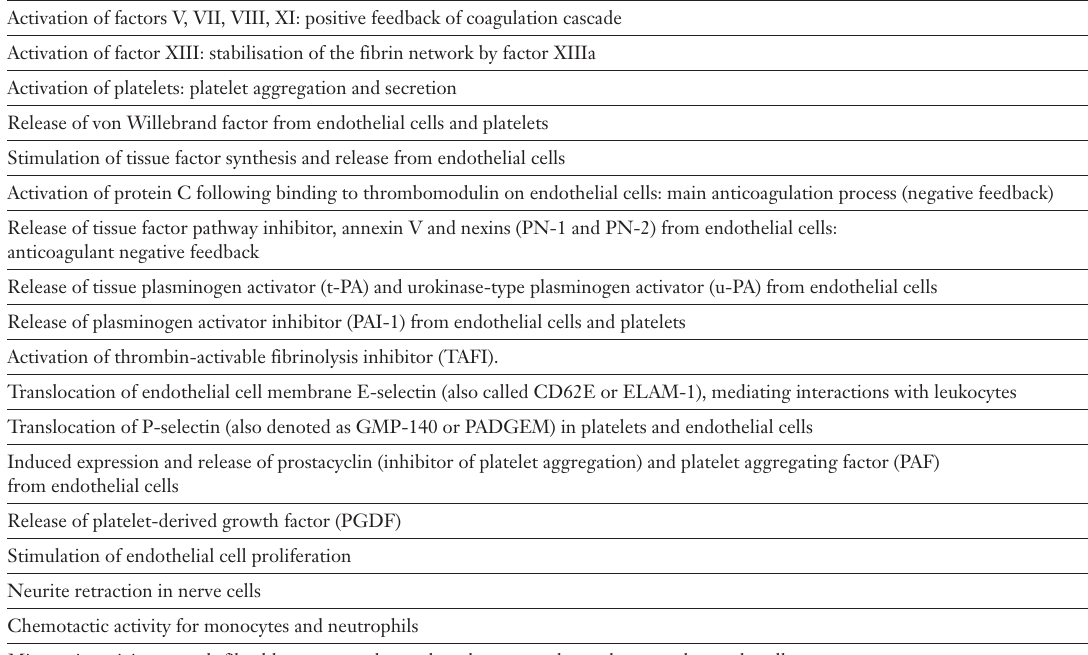
Thrombin functions in response to vascular